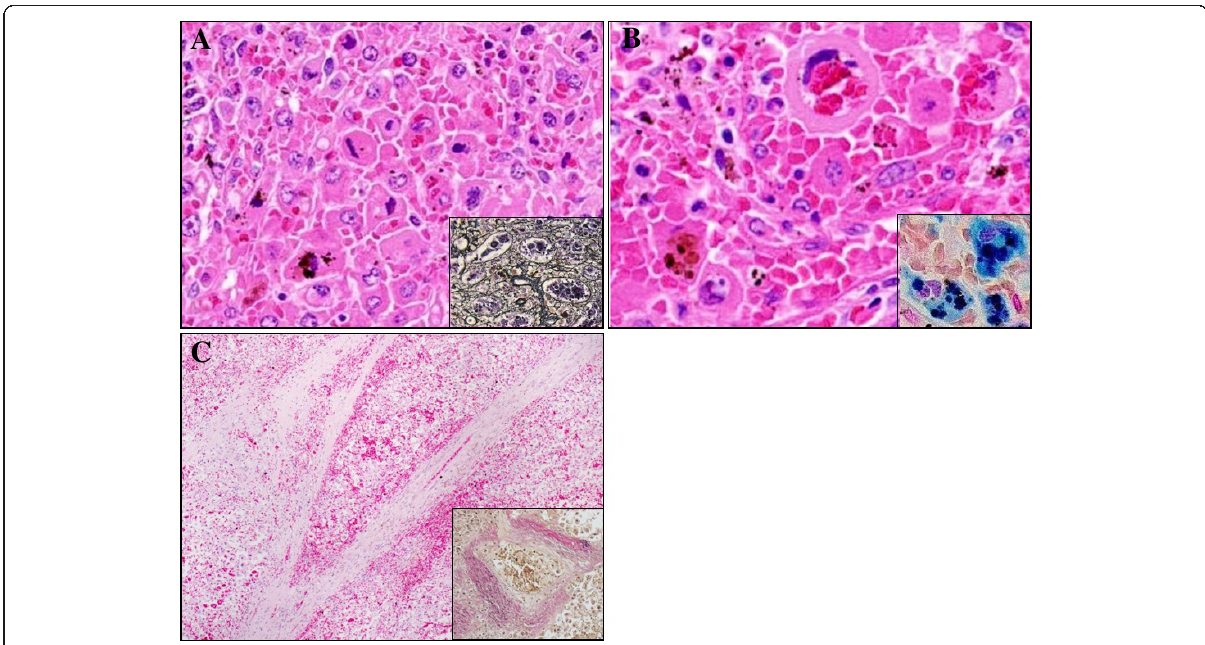
Figure 3 Histological examination of splenic HS. ( A ) The spleen predominantly showed a diffuse proliferation of medium-sized to large tumor cells having mildly hyperchromatic and pleomorphic nuclei, prominent nucleoli, and abundant eosinophilic or clear cytoplasm, mainly within the sinuses and cords of the red pulp, highlighted by silver impregnation (inset) (H&E stains, Original magnification × 200). ( B ) On high-power view, these large tumor cells exhibited apparent hemophagocytosis of red blood cells or mononuclear lymphocytes (H&E stains, Original magnification × 400). Hemosiderin pigments within the large cells confirmed erythrophagocytosis by Berlin-blue staining (inset). ( C ) Vascular invasion of these tumor cells was noted in the trabecular artery, very likely inducing multiple foci of peripheral anemic infarction (H&E stains, Original magnification × 40). This could make a clear contrast by elastica van Gieson (EVG) staining (inset).